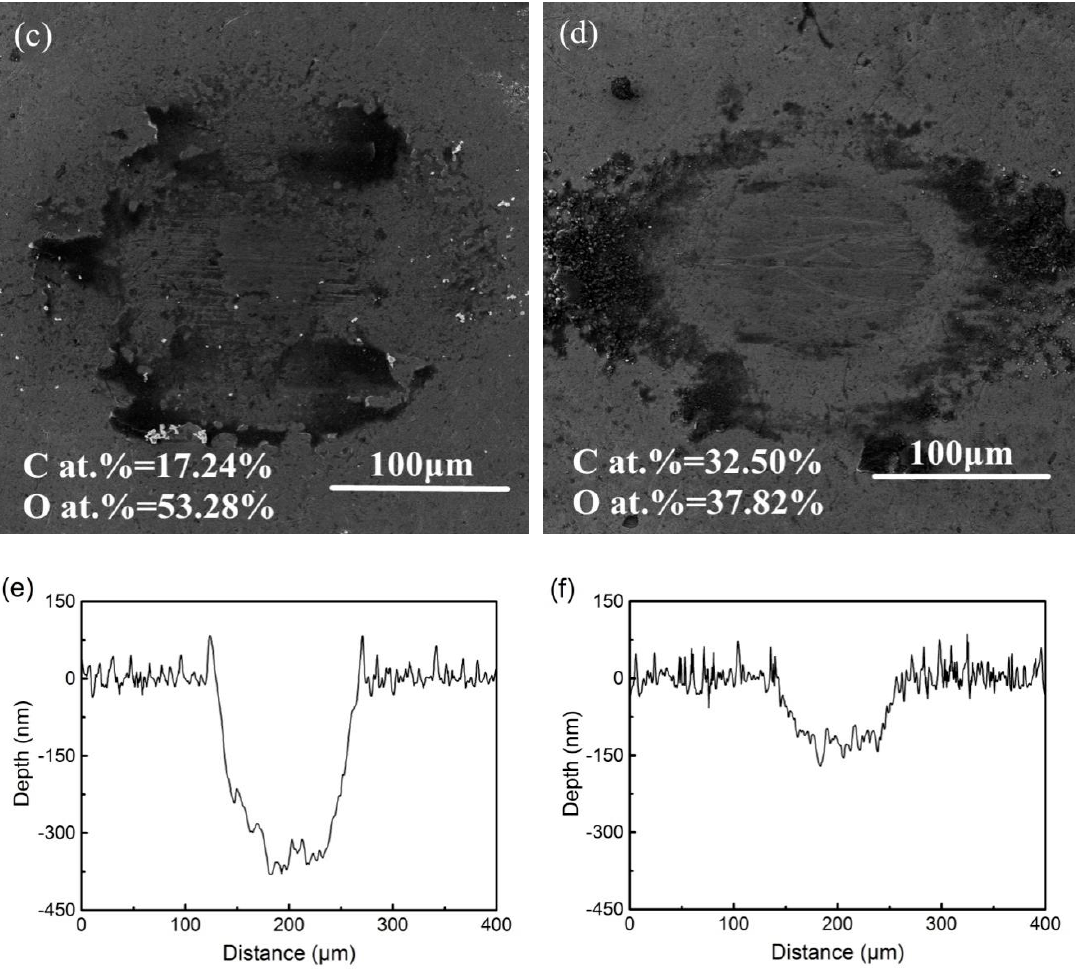
Figure 10. The wear scratch morphology and cross-section of DLC-Ti6Al4V: ( a , c , e ) Sample 3; ( b , d , f ) Sample 6.